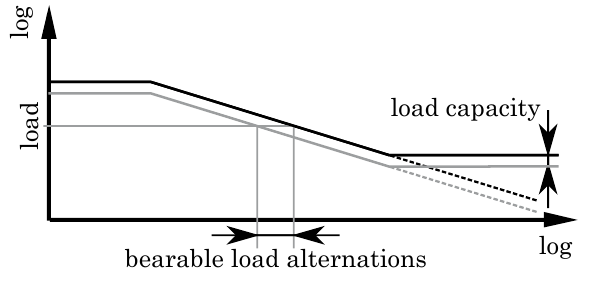
Figure 8: Sensitivity W¨ohler-curve